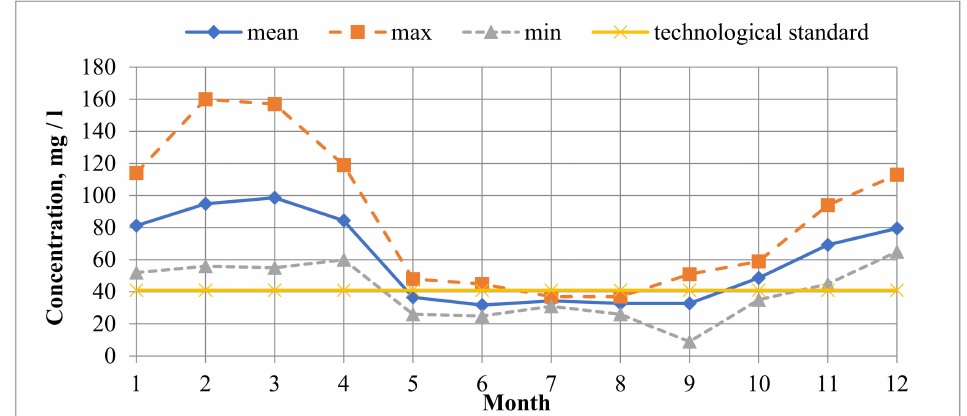
Figure 4. Monthly change in the content of chlorides in the water at the technical water intake BKPRU-4, Uralkali from 2015 to 2020.